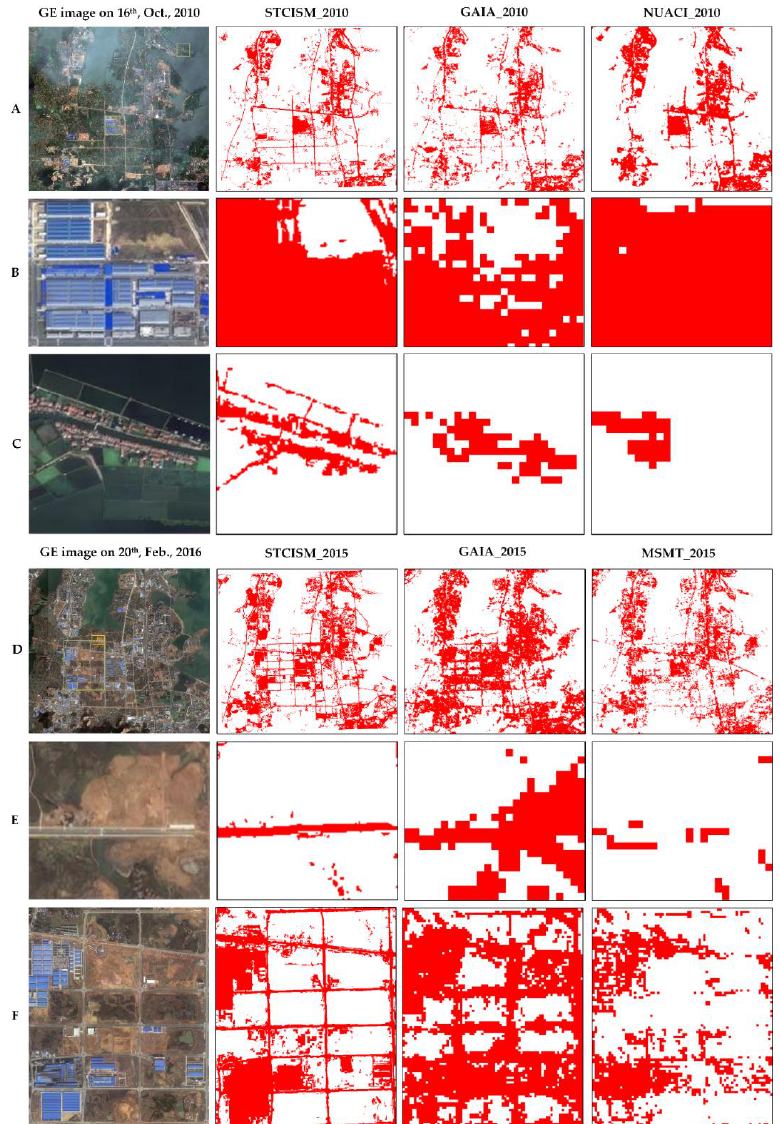
Figure 7. Visual comparison between our impervious surface maps and other products: Google Earth (GE) images acquired on 16 October 2010, and 20 February 2016; for 2010, Spatiotemporal Continuous Impervious Surface Mapping (STCISM) dataset; Global Artificial Impervious Areas (GAIA) dataset, and Normalized Urban Areas Composite Index (NUACI) dataset; and for 2015, STCISM dataset, GAIA dataset, and Multisource, Multitemporal (MSMT) dataset. Red and white represent impervious and pervious surfaces, respectively. ( A , D ) Entire area. ( B , C ) Selected areas in (A). ( E , F ) Selected areas in